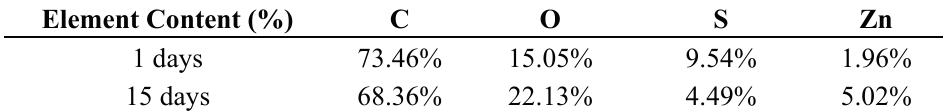
Figure 16. XPS spectra of ( a ) C; ( b ) S; ( c ) Zn and ( d ) O elements for P3HT-ZnO hybrid thin film stored after 1 and 15 days. Table 2. The element contents of P3HT-ZnO film surface for 1 day and 15